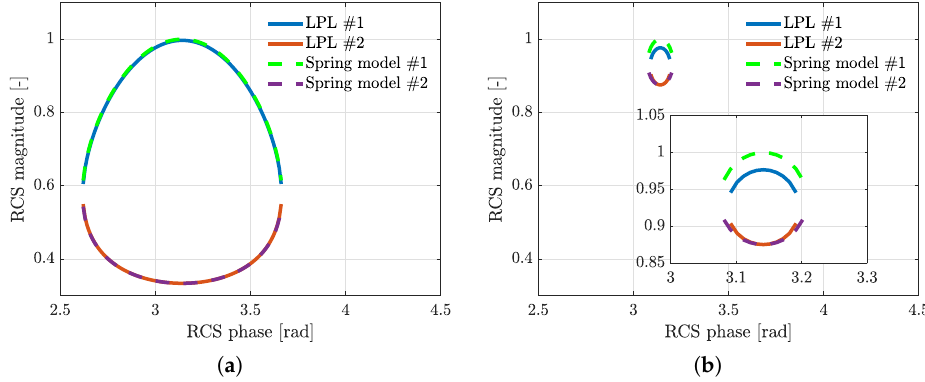
Figure 3. Magnitude as a function of the phase of the reflection coefficient spectrum for: ( a ) R 1 = − 0.95 and R 2 = 0.89, Θ = 0.997. ( b ) R 1 = − 0.95 and R 2 = 0.41, Θ =